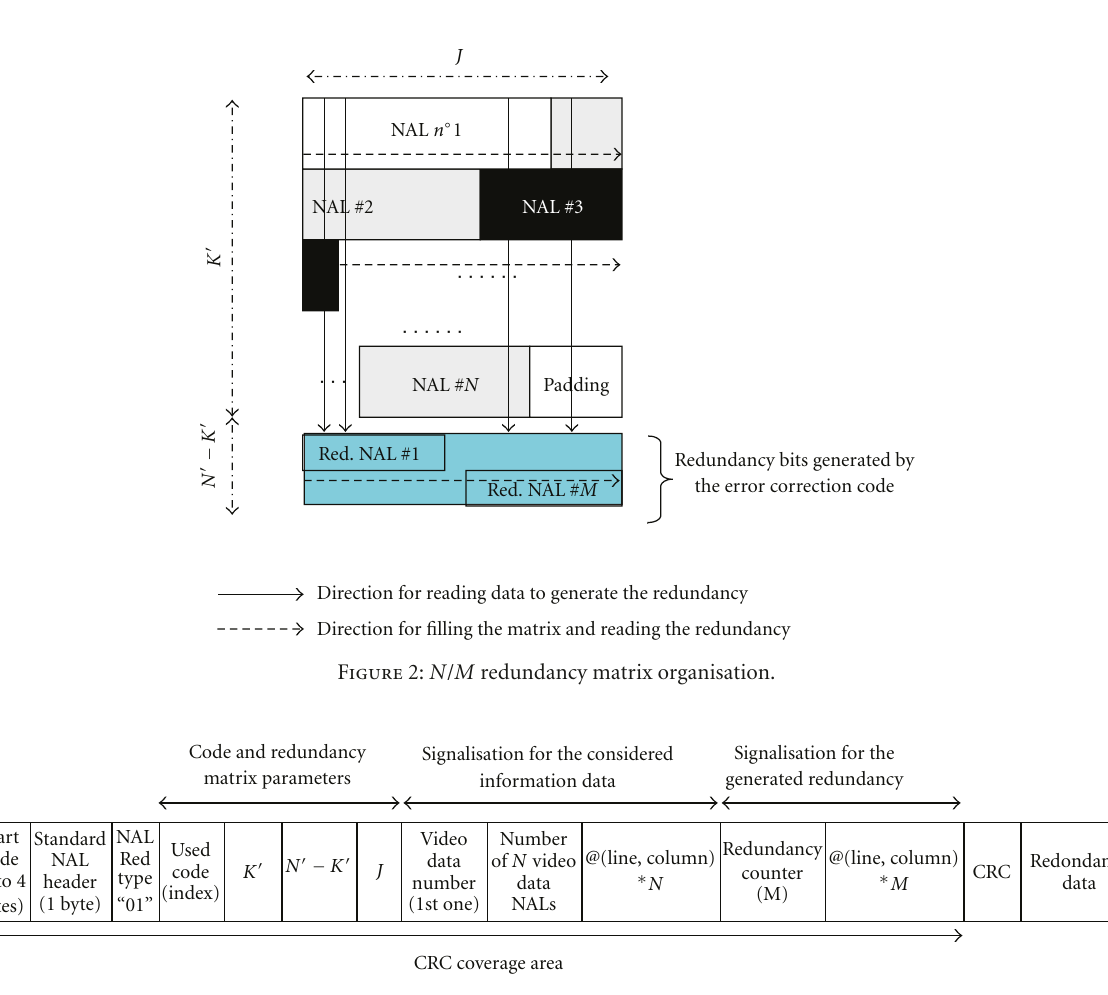
Figure 3: N / M NAL unit 30 proposed format, type “01”.